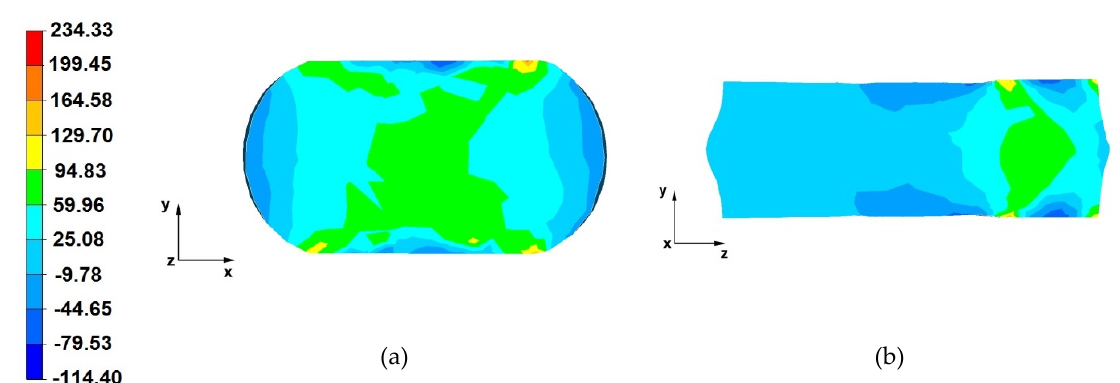
Figure 8. Distribution of the hydrostatic pressure of the AZ 91 alloy forging, deformed in the third pass with 40% reduction in flat anvils: ( a ) on the cross-section, ( b ) on the longitudinal section.